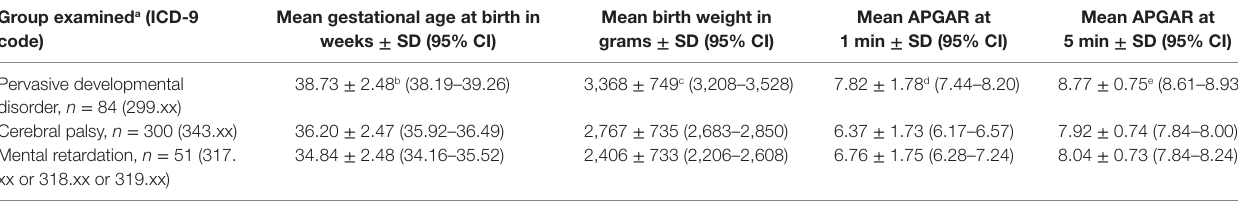
Mean birth weight in grams ± sD (95% ci)